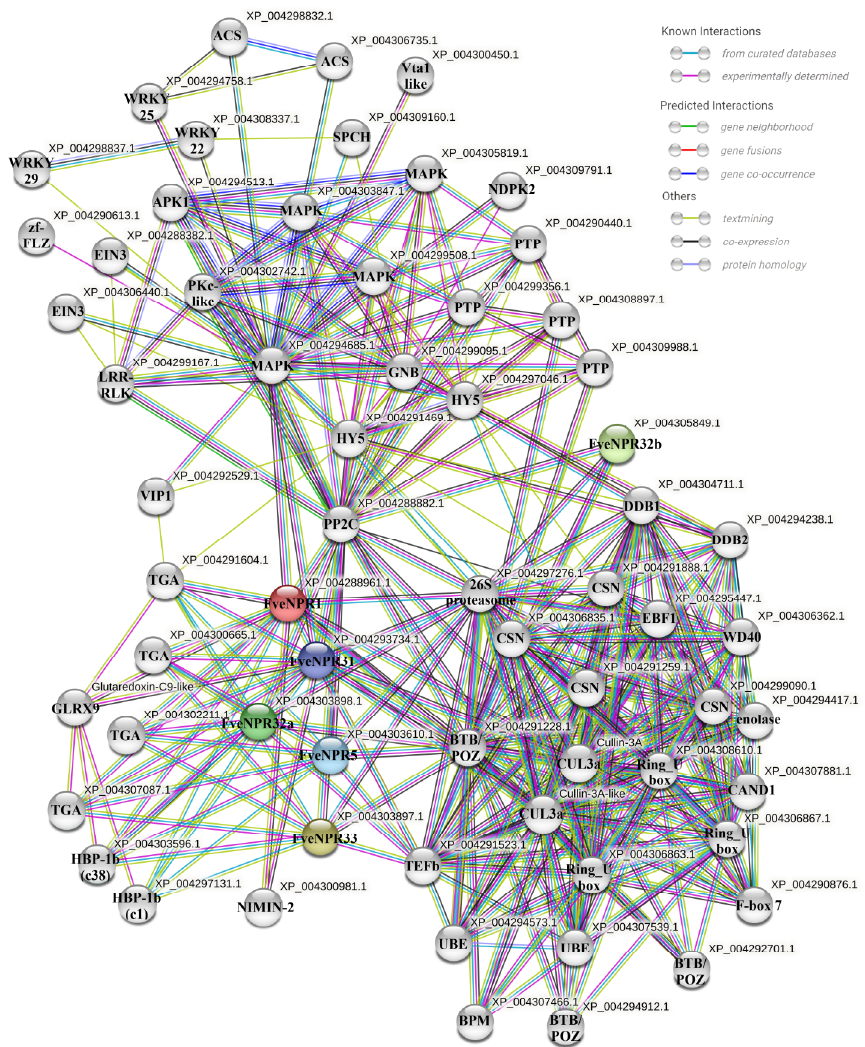
Figure 8. The protein–protein interaction networks proposed for the strawberry FveNPR1-like proteins in STRING (https://cn.string-db.org, accessed on 26 February 2022). The edges in different colors represent the predicted interaction relationships according to different methods. The detailed information for all potential partners is shown in Figures 9 and S3.